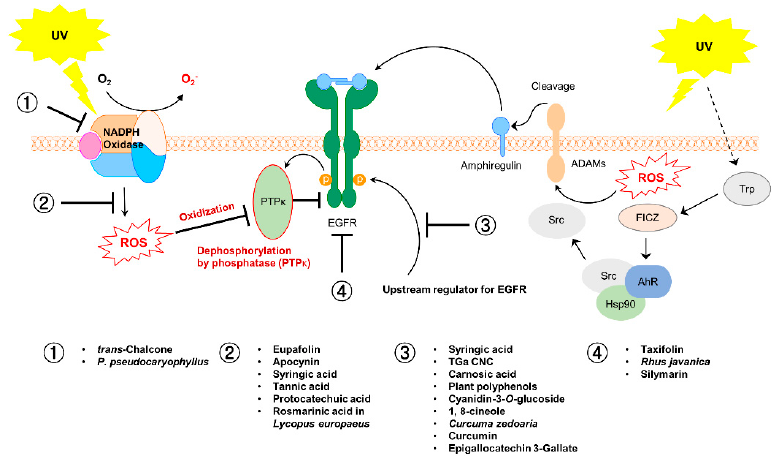
Figure 3. Summary of the mechanism of the effect of botanical extracts and phytochemicals in response to UV irradiation.